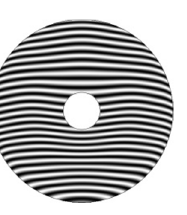
Fig. 3. Model interferogram of the required wavefront and parameters of wavefront deviations.